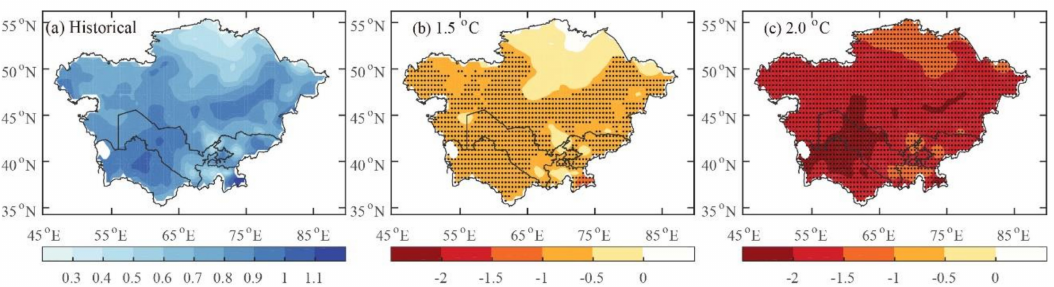
Figure 9. The spatial distribution of standardized precipitation evapotranspiration index (SPEI) in the reference period (1986–2005) ( a ) and the di ff erence under 1.5 ◦ C ( b ) and 2 ◦ C ( c ) global warming relative to the reference period. Dark gray dots indicate that the decreasing trends are significant at the 1% level in these